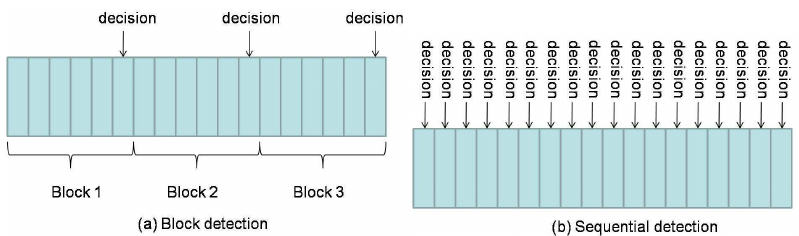
Figure 4. Illustrations of block and sequential